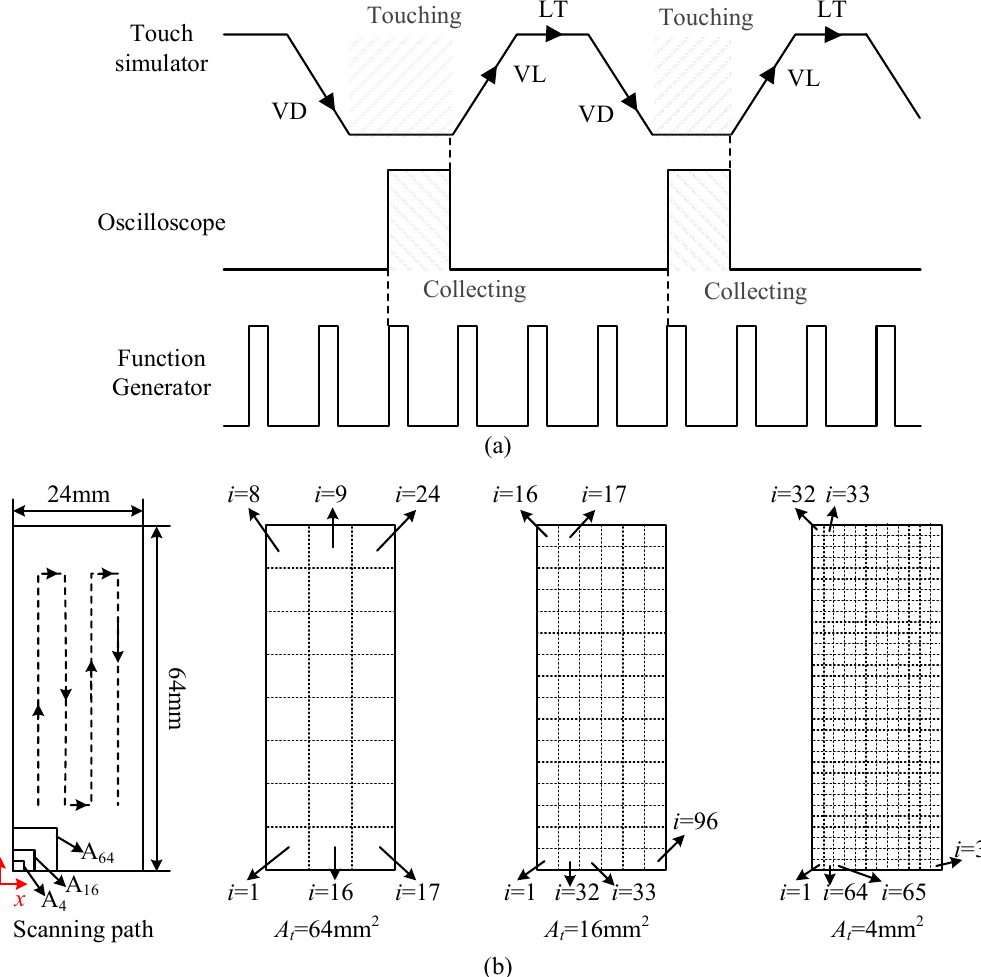
Figure 2. Automatic data acquisition scheme: ( a ) sequence diagram of the system and ( b ) pattern of pixel division and scanning path of the touch simulator.